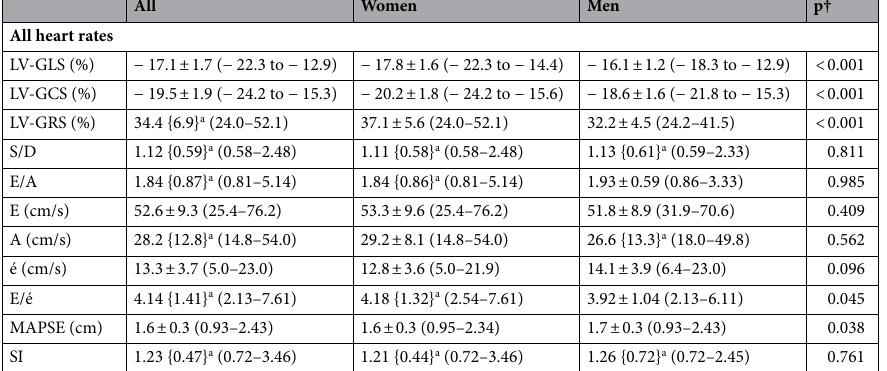
Table 5. Cardiovascular functional parameter of the subgroup with heart rates between 60 to 75 beats-per- minute. Normally distributed values were expressed as mean ± standard deviation, otherwise as median ( a ) with interquartile range. Ranges in parentheses. † p-value related to gender. Normally distributed data were tested by the unpaired t-test, otherwise with the Mann–Whitney-U-test. LV-GLS left ventricular global longitudinal strain, LV-GCS left ventricular global circumferential strain, LV-GRS left ventricular global radial strain, S/D ratio S-wave to D-wave by quantitative right upper pulmonary vein blood flow measurements, E/A ratio E-wave to A-wave by quantitative transmitral blood flow measurements, E E-wave by quantitative transmitral blood flow measurements, A A-wave by quantitative transmitral blood flow measurements, é mean lateral and septal cine CMR velocities, E/é ratio E-wave to é, MAPSE Mitral annulus plain systolic excursion, SI Sphericity